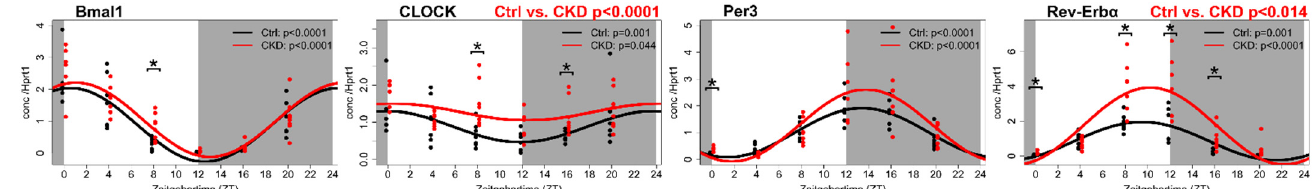
Figure 3. Disturbed expression of circadian clock genes in the uremic aorta after 8 weeks of CKD. Expression profiles of the core circadian clock genes in the aorta after 8 weeks of uremia (red lines) ( n = 44) are compared to the normal controls (black lines) ( n = 39). Dots represent each animal. Data are fitted by Cosinor regression, and the resulting p -values are shown within the figures. Gray areas indicate the dark period, and white areas indicate the light period. Zeitgeber time (ZT; “time-giver”) is the time since light onset. A significant difference in the Mesor (rhythm-adjusted mean) is indicated on top of the single figures. * Indicates a significant difference ( p < 0.05) between the groups at specific time points. Data were previously presented in reference [48] and reprinted with permission from Kidney Int.